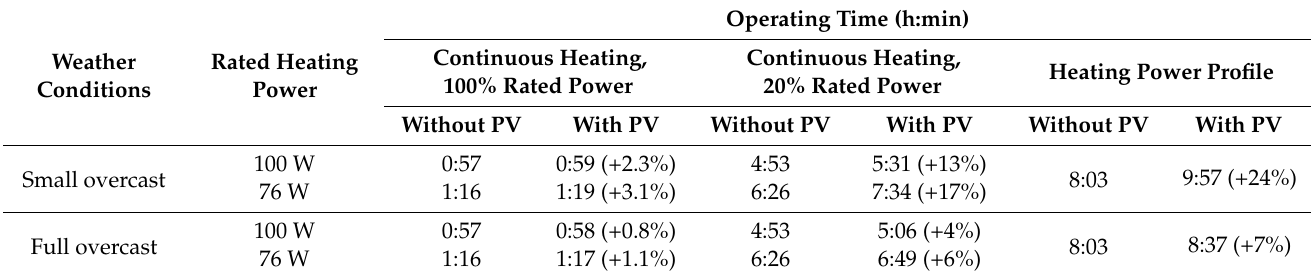
Table 10. System operating times without and with PV modules in their backpack option 2 configura- tion, for a realistic use case of the heating